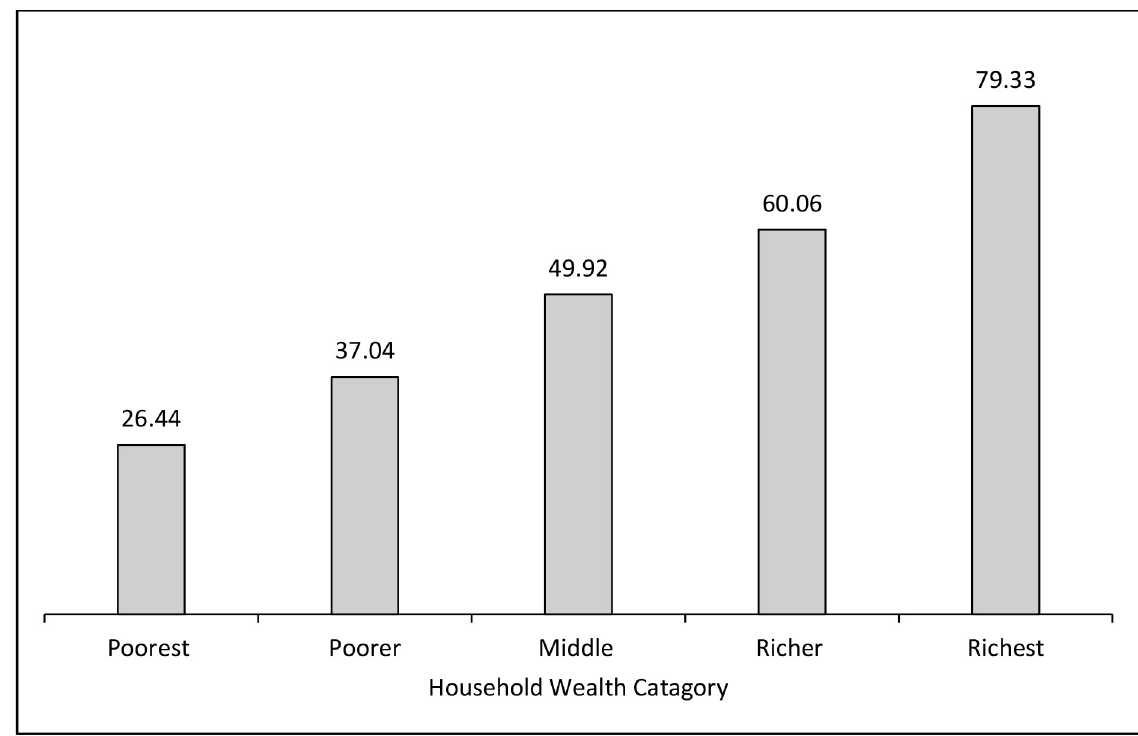
Fig 1. Facility delivery by household wealth